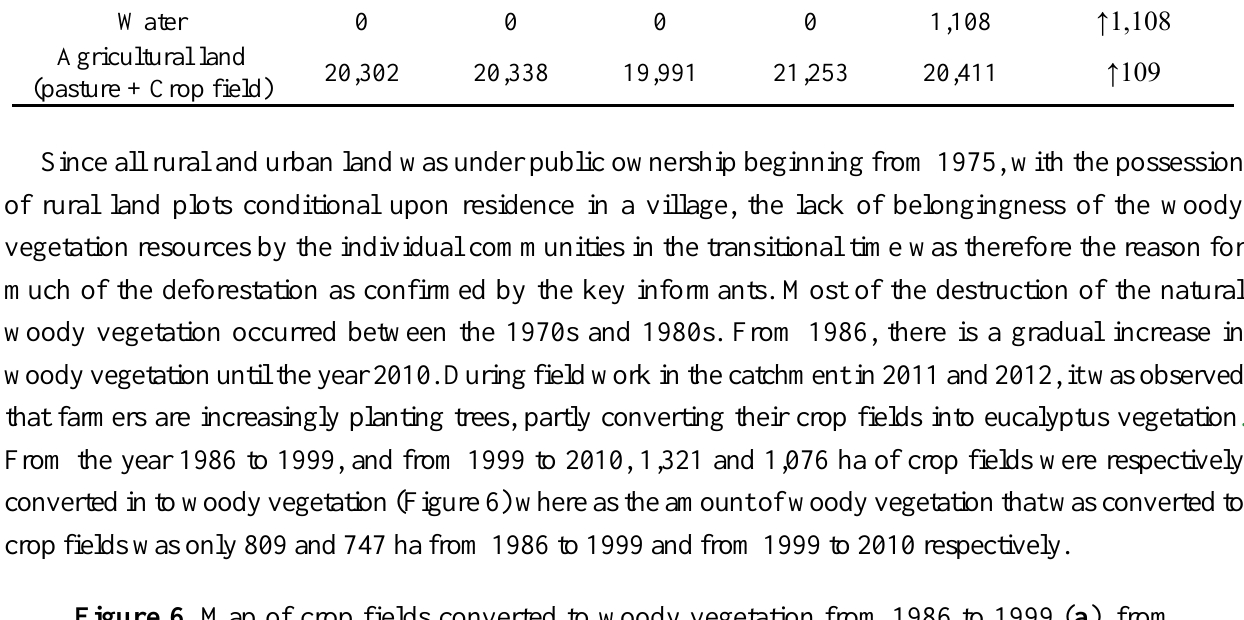
Figure 6. Map of crop fields converted to woody vegetation from 1986 to 1999 ( a ), from 1999 to 2010 ( b ), from 1986 to 2010 ( c